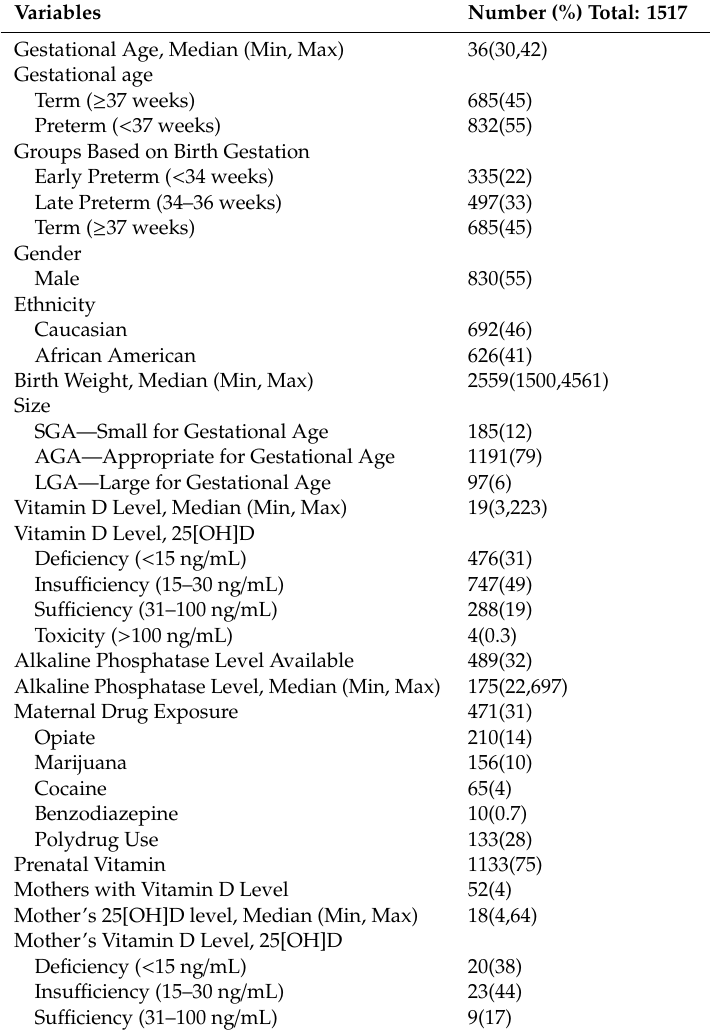
Table 1. Maternal and infant descriptive